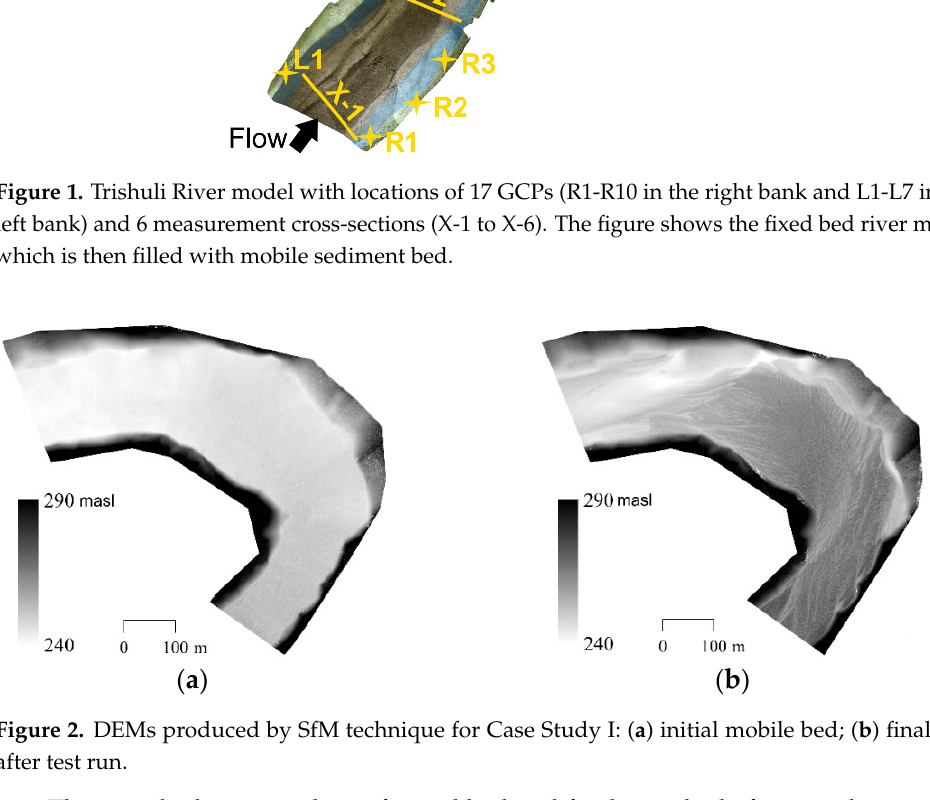
Table 1. Processing time and output quality for Case study I.